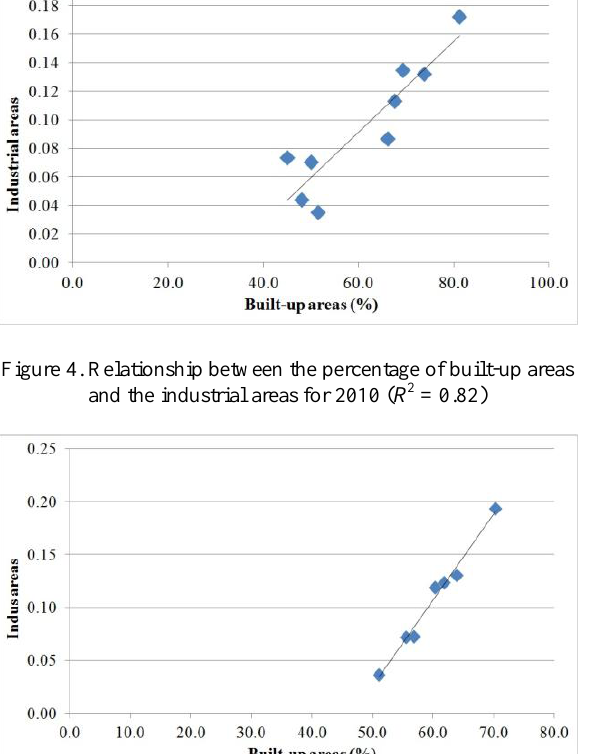
Table 2. A summary of built-up areas and industrial areas in 2010 for the nine cities in Canada